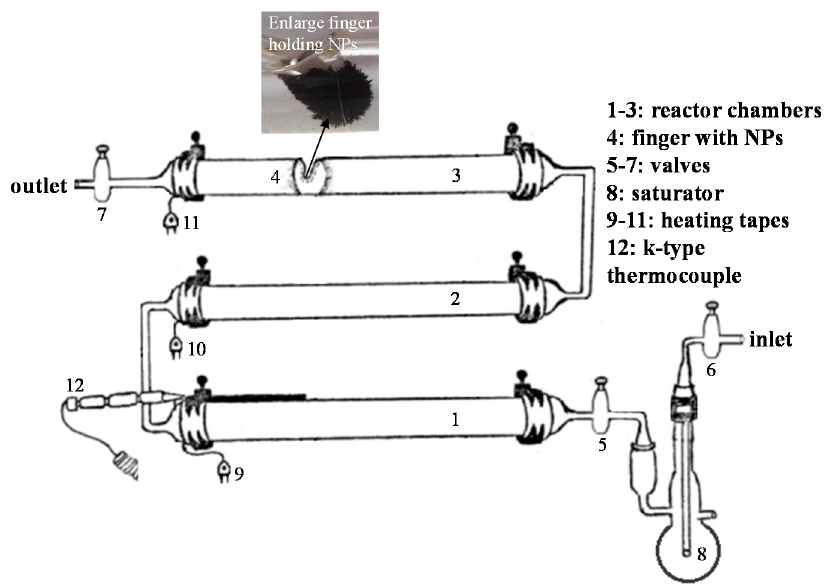
Figure 1. Experimental set-up of methanol synthesis.